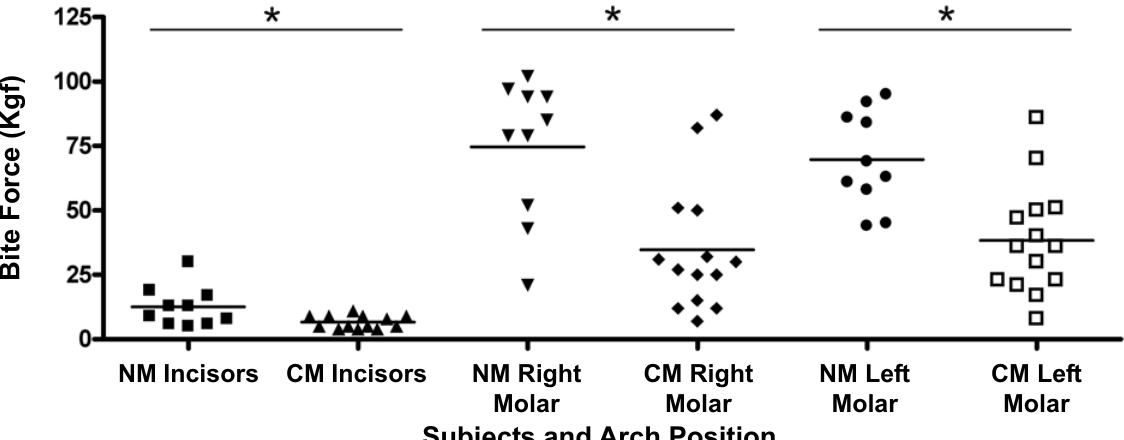
FIGURE 1- Maximum isometric bite force in the male group: Noncleft male subjects (NM) and repaired cleft lip and palate male patients (CM) (kgf). Data representative of values performed by each subject. Statistically significant difference observed between NM and CM subjects (*)